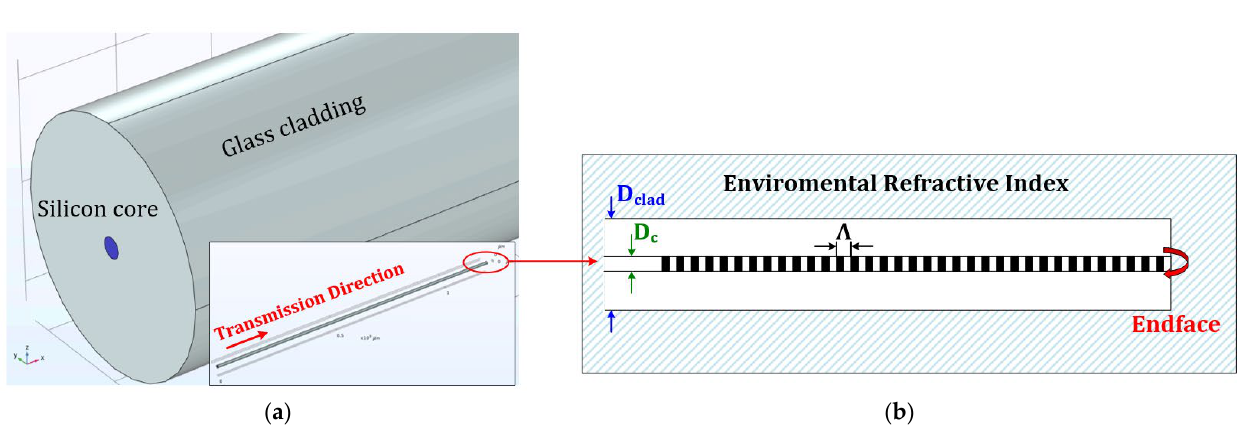
Figure 1. ( a ) 3D structure of fiber Bragg grating in COMSOL Multiphasic and ( b ) cross-section of silicon core-based fiber Bragg grating.